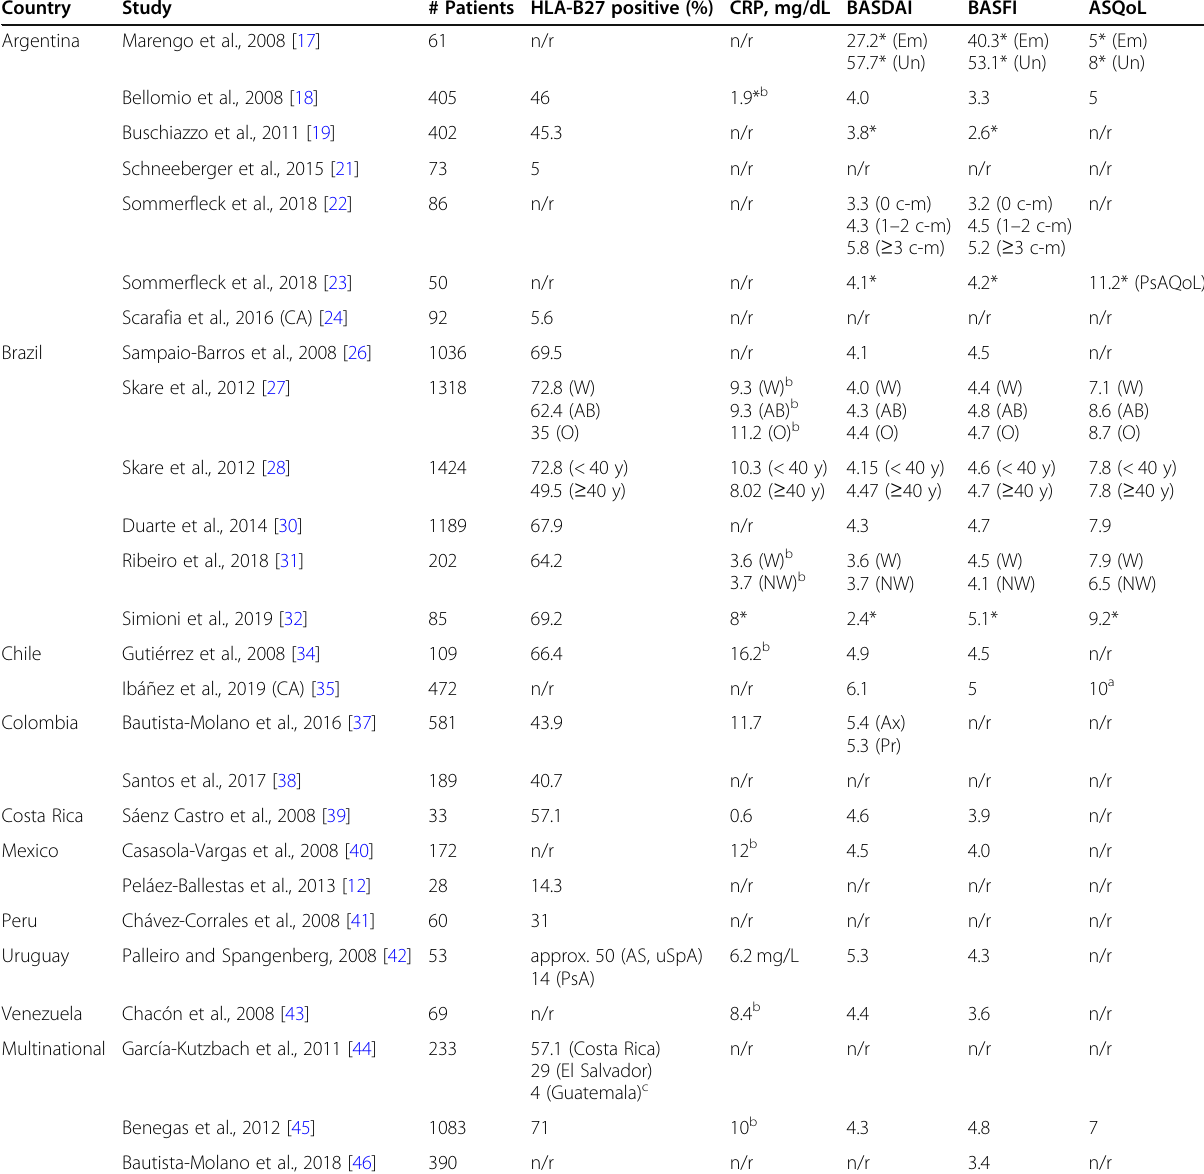
Table 3 Clinical characteristics of patients with SpA across Latin America Country